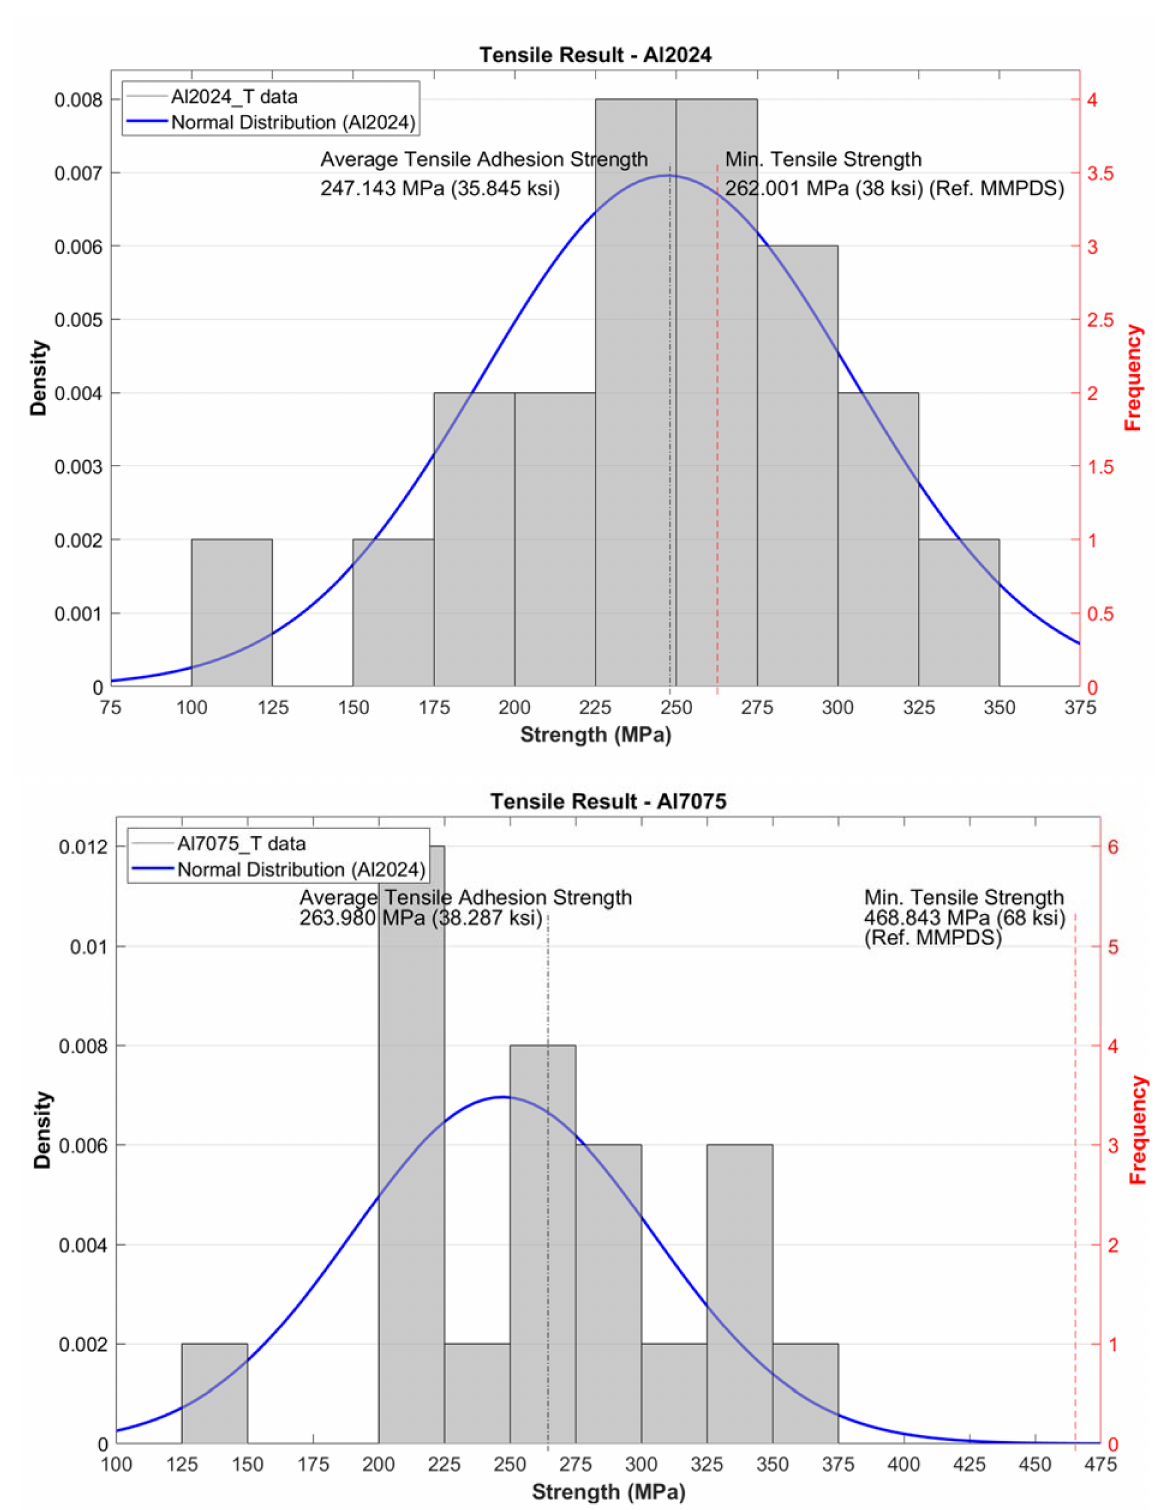
Figure 10. Normal distribution histogram and curve of the tensile strength results of both cold- sprayed Al-2024 and Al-7075 coating